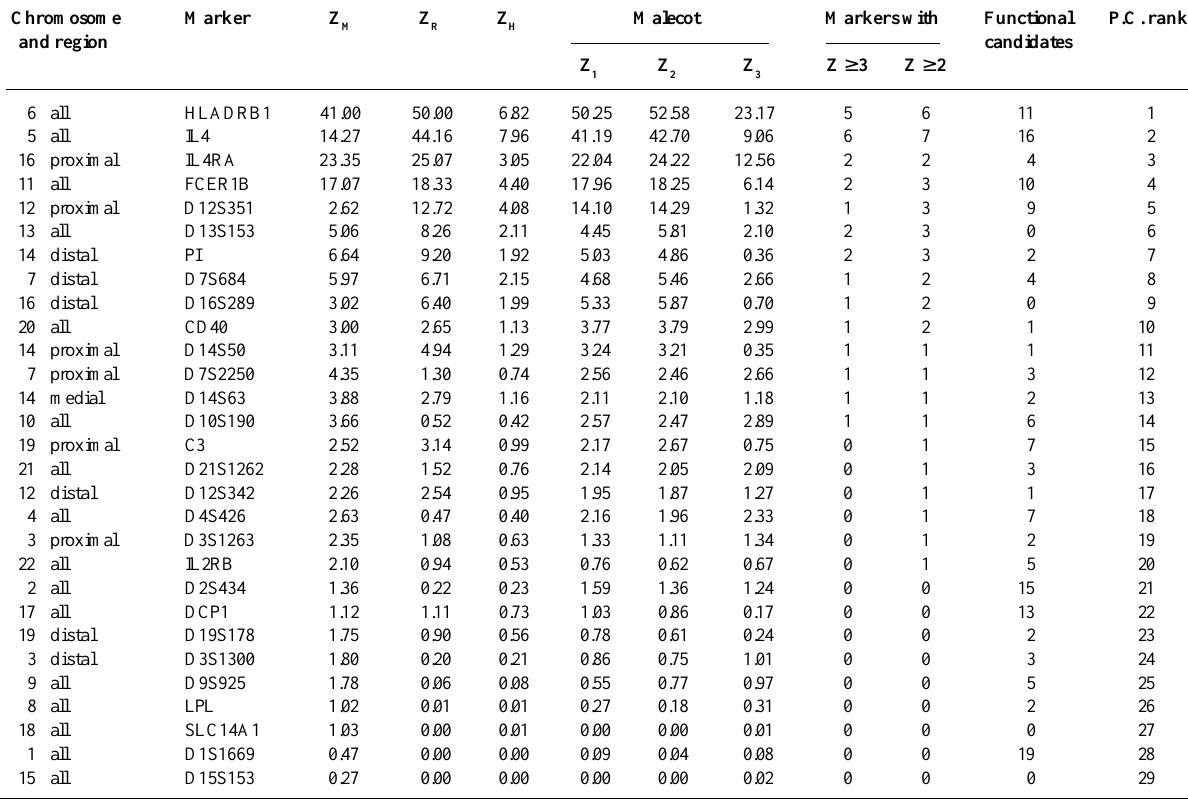
Table I - Chromosomes and candidate